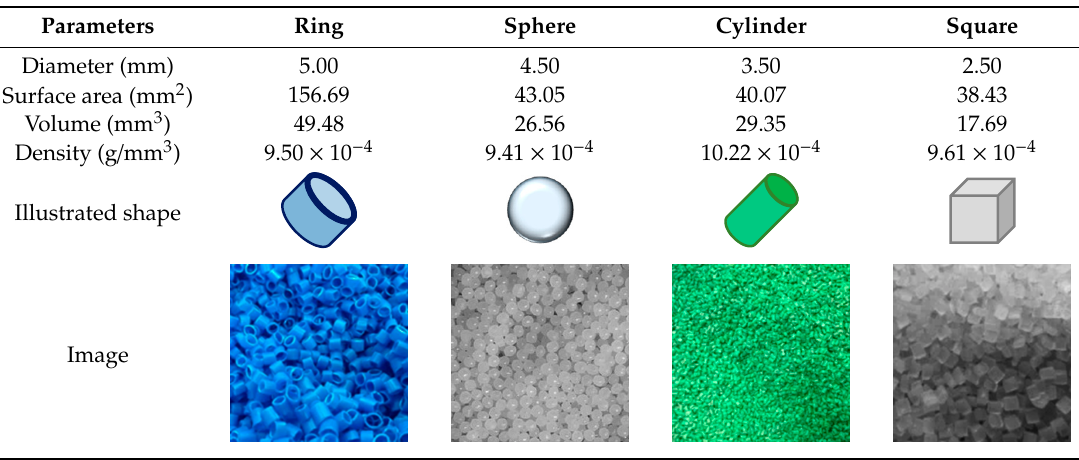
Table 1. Physical properties and characteristics of solid media used in this study.